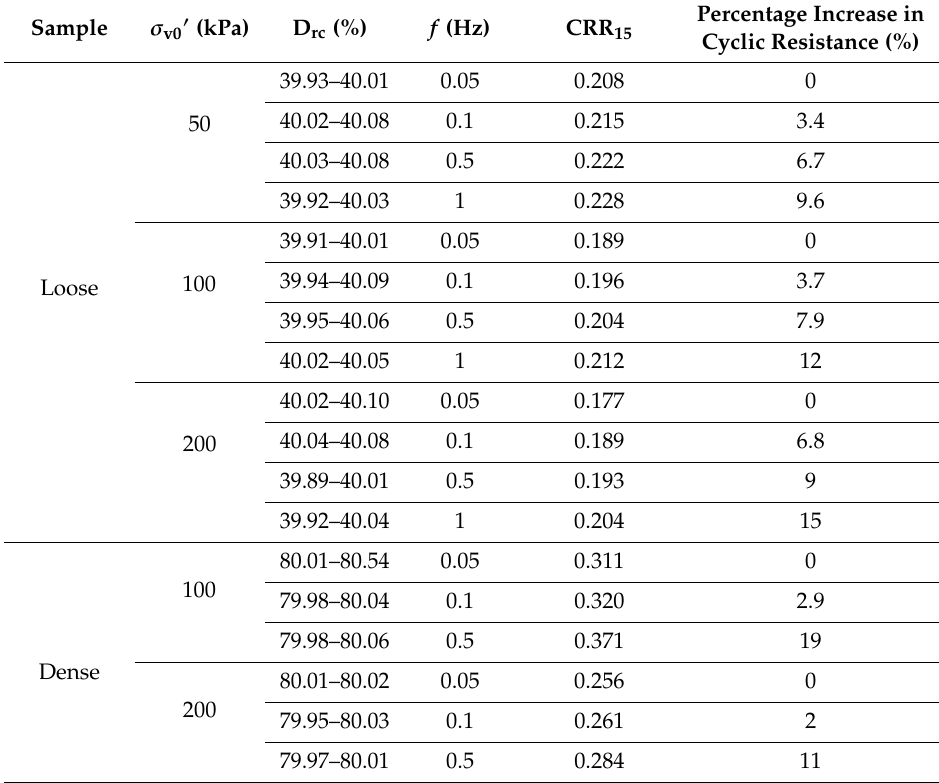
Table 3. Summary of direct cyclic shear